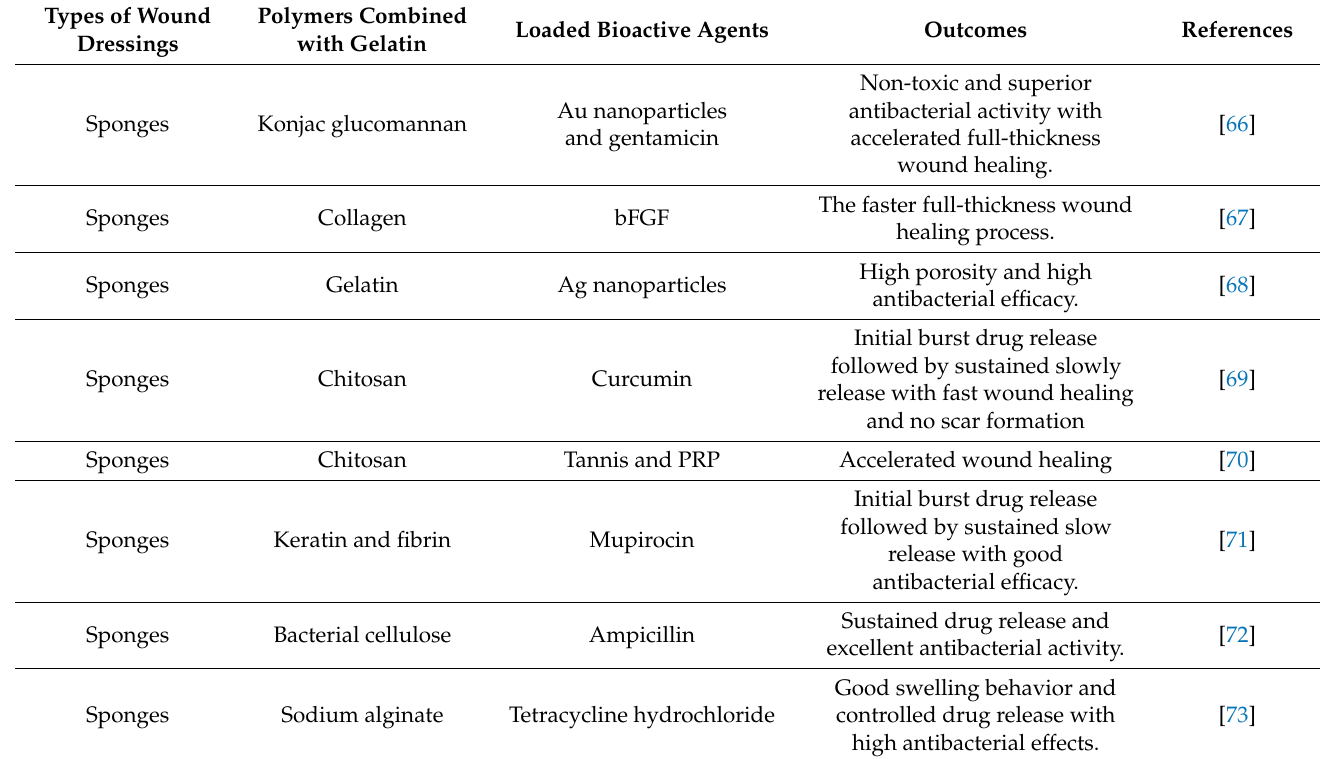
Table 3. Summary of Gelatin-based hybrid Sponge Wound